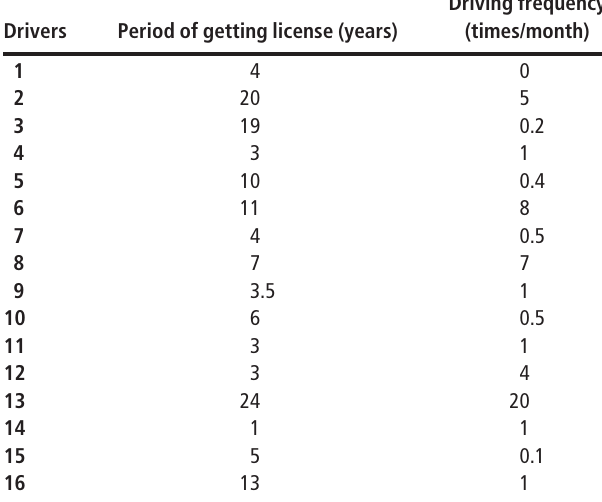
Table I Information of drivers